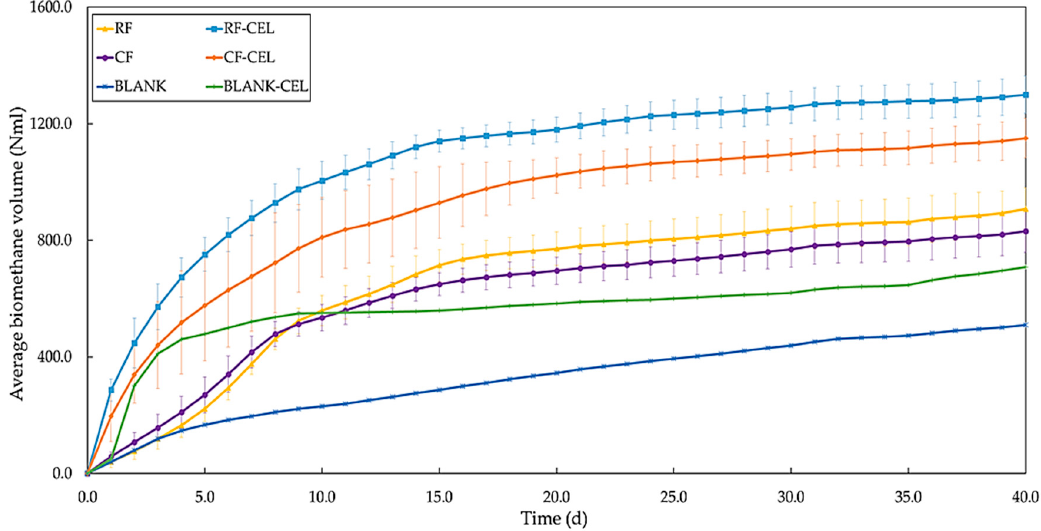
Table 6. Specific methane yield of samples.